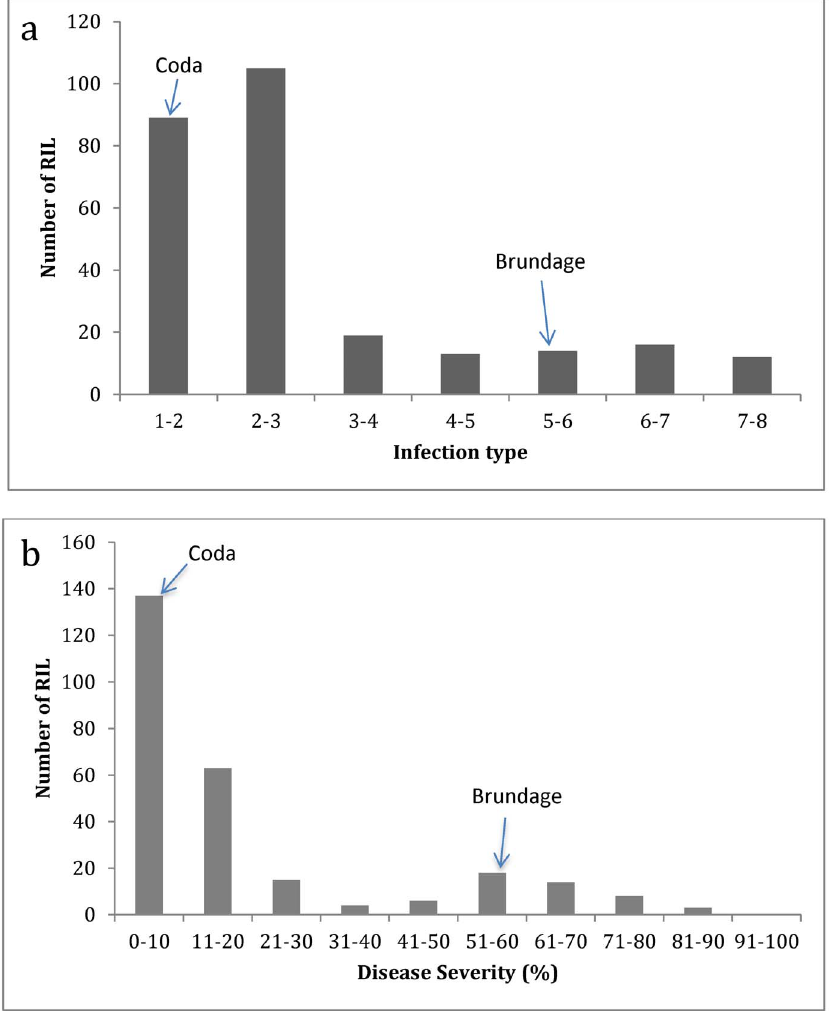
Figure 1. Distribution of infection in the Brundage by Coda RIL population. Distribution of: ( a ) infection type (IT) and ( b ) disease severity (DS) grand mean (averaged over all locations) values. Arrows indicate resistant parent (Coda) and susceptible parent (Brundage) score groups.